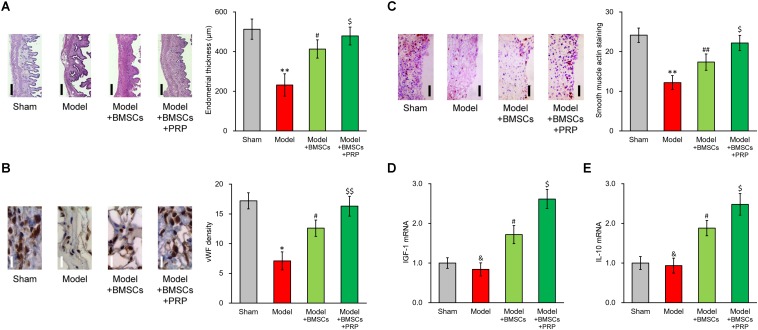
PRP therapy enhances BMSC transplant in treating injured rat uterus. Rats were divided into sham, model, model receiving only BMSC transplant (Model + BMSCs) and model receiving both BMSC transplant and PRP therapy (Model + BMSCs + PRP), with eight rats per group. 28 days after the treatment, (A) representative histological images (left side, scale bar 100 μm) and bar graph showing endometrial thickness in the regenerative uterine horns, (B) representative histological images (left side, scale bar 20 μm) and bar graph showing neovascularization measured as vWF staining density in the newly regenerated uterine endometrial, (C) representative histological images (left side, scale bar 50 μm) and bar graph showing smooth muscle regeneration measured as smooth muscle actin staining, were assayed in the experimental animals. (D,E) mRNA levels of IGF-1 (D) and IL-10 (E) were examined in regenerated endometrium samples 28 days after the treatment. Values are mean ±SD (n = 8 each group). ∗∗P < 0.01, ∗P < 0.05, &P > 0.05, vs. sham. #P < 0.05, ##P < 0.01, vs. both sham and model. $P < 0.05, $$P < 0.01, vs. both model and model + BMSCs.